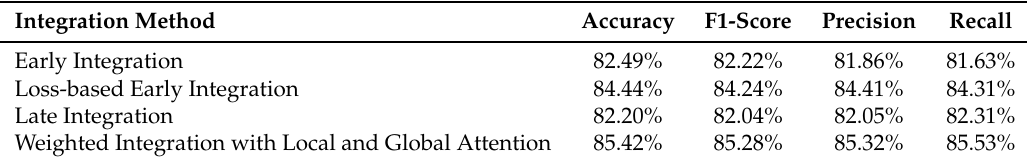
Table 5. Performance of different integration